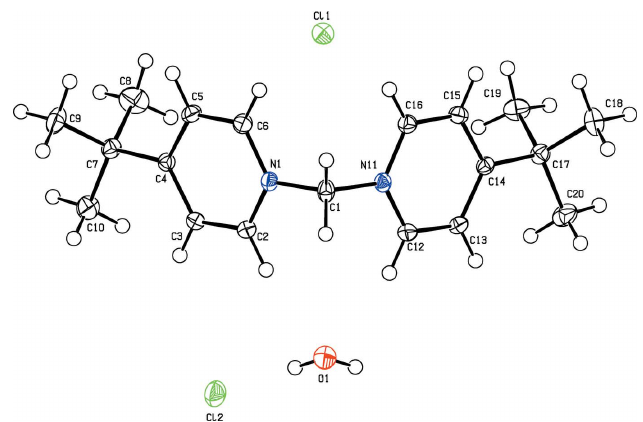
Figure 1 Molecular structure of the title compound with atom labels. Displacement ellipsoids are at the 50% probability level.